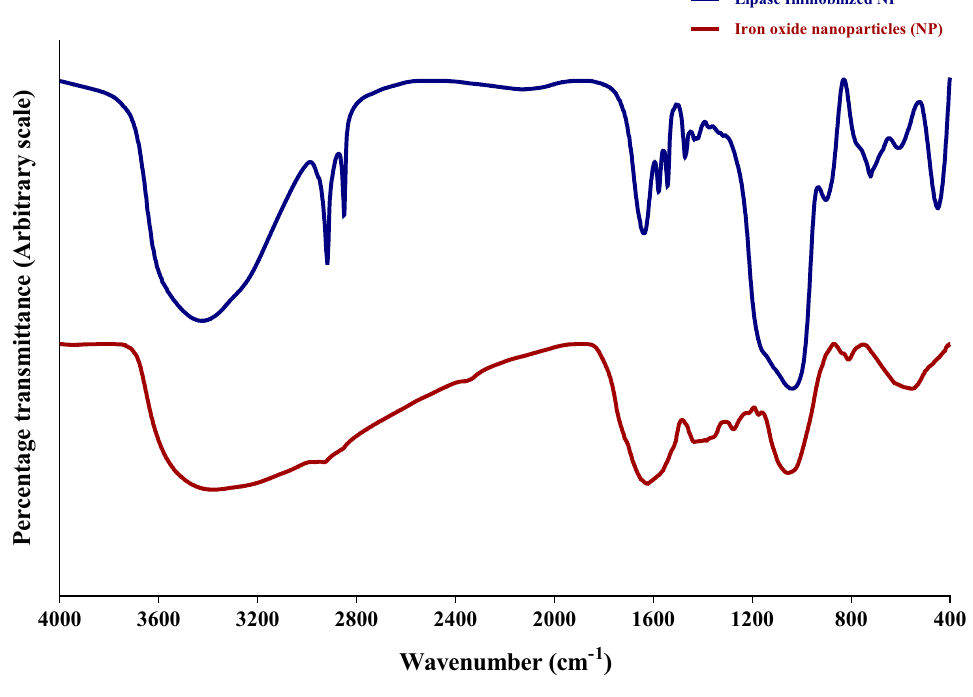
Figure 3. FT-IR Spectrum of bare Fe 2 O 3 Nanoparticles and lipase immobilized